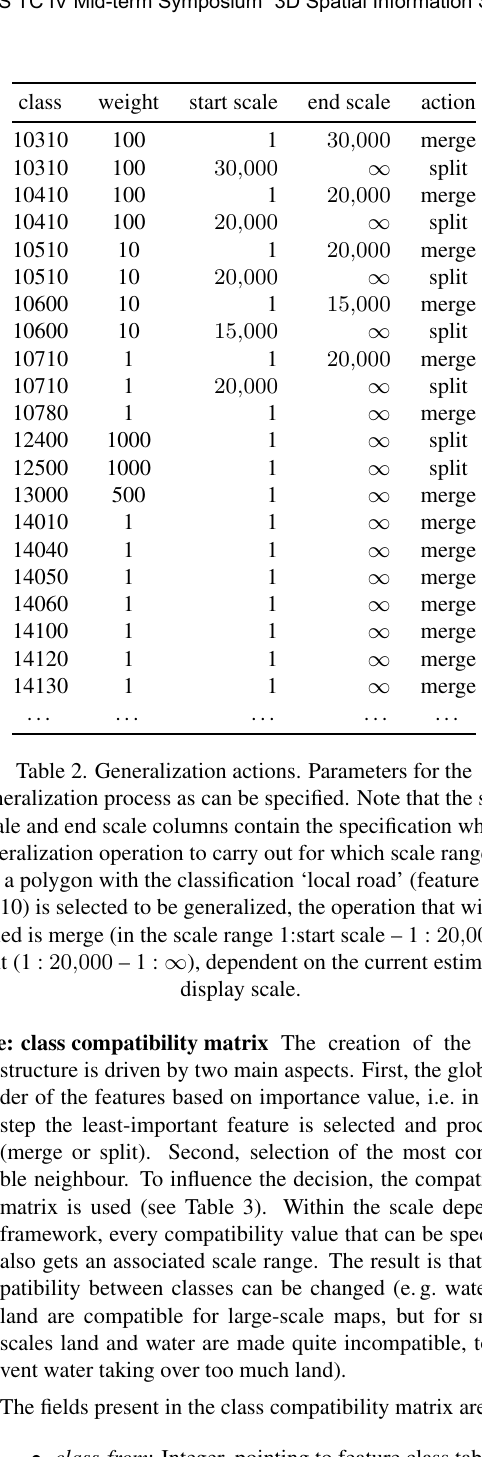
Table: attractiveness regions For storing the information about the regions, we use the following